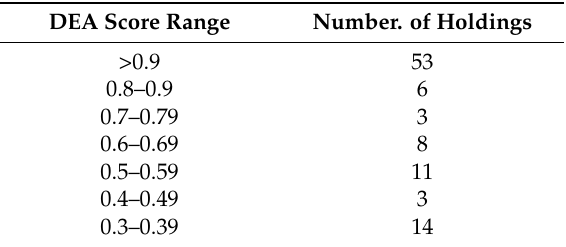
Table 5. Detailed DEA scores.